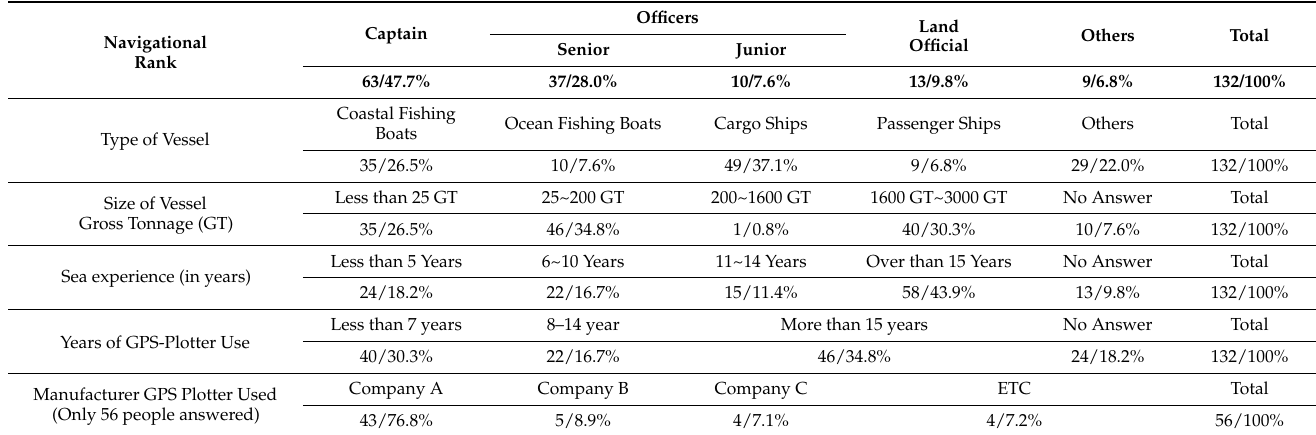
Figure 4. ( a ) Rank of the respondents; ( b ) average years of GPS plotters use. Table 4. Characteristics of the respondents.